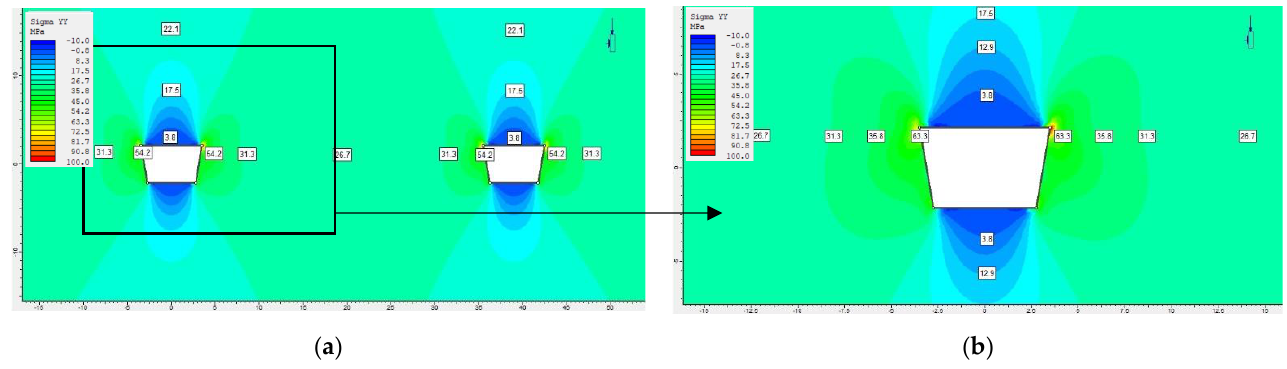
Figure 6. Distribution of σ YY stresses in the cross-section through ramps drilled in sandstone: ( a ) view of both headings; ( b ) close-up of a single excavation.